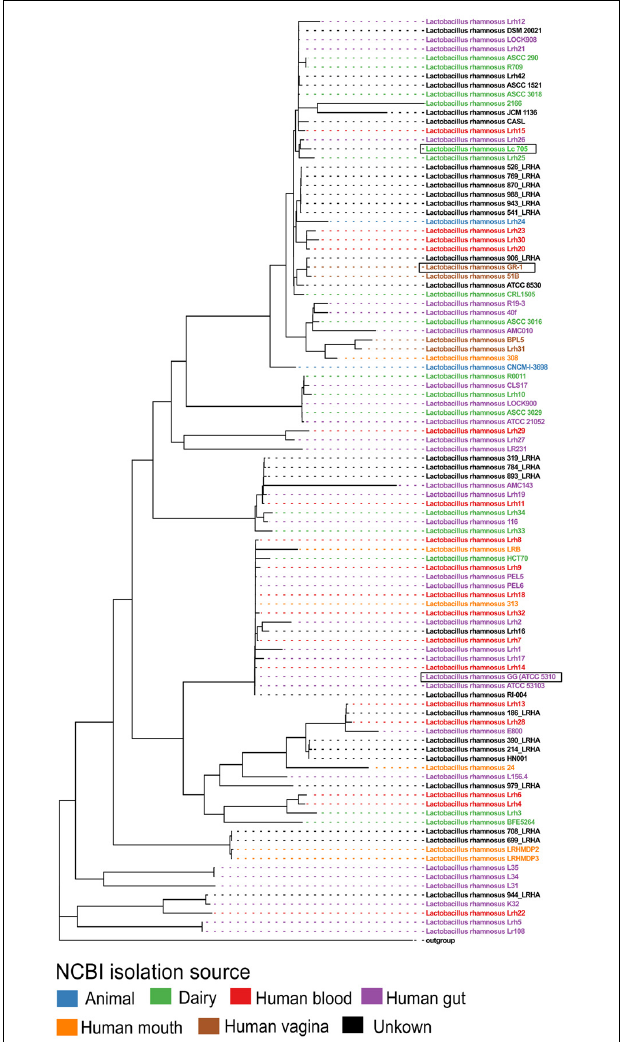
FIGURE 1 | Phylogenetic tree of all publicly available Lactobacillus rhamnosus strains including L. rhamnosus GR-1, based on the amino acid sequences of 952 single copy core orthogroups with Lactobacillus casei subsp. casei ATCC 393 (GCA_000829055) as outgroup. The branch length of the outgroup was shortened for visualization